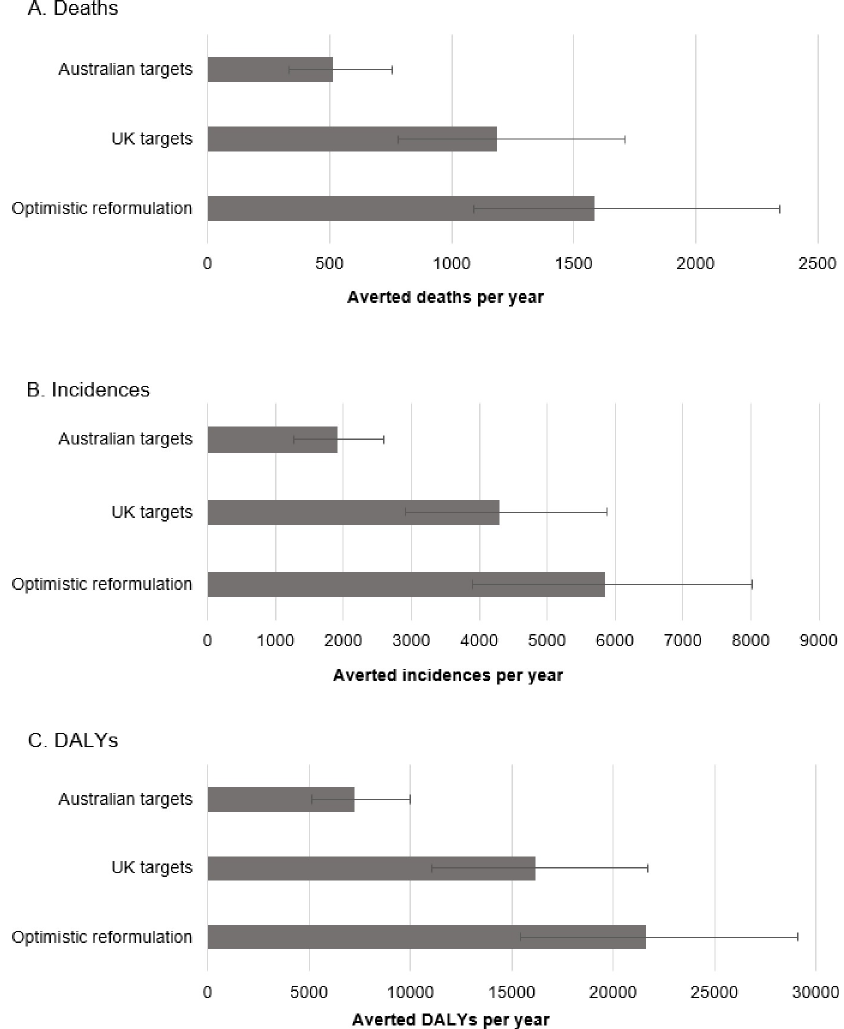
Fig 2. Total number averted deaths (A), incidences (B), and DALYs (C) per year estimated by intervention. The error bars indicate the 95% UIs. The reformulation targets for the optimistic reformulation program was defined in each of 76 food groups targeted by the UK reformulation program as the sales-weighted 25th percentile of sodium content in that specific food group. HFP, Australian government’s Healthy Food Partnership sodium reformulation targets. DALY, disability-adjusted life year; UI, uncertainty